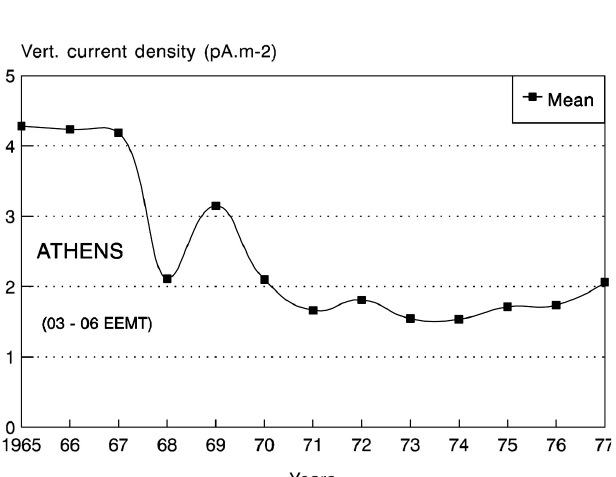
Fig. 4. (a) Ionospheric potential soundings made by M¨uhleisen and Fischer above Weissenau, Germany (from Budyko, 1971). Least- square regression lines have been fitted to all the data, and to the class 1, 2, 3 soundings (ascent and descent values within 20%) from 1965. (b) Changes in the air-Earth current density (based on dawn data) at Athens from 1965 to